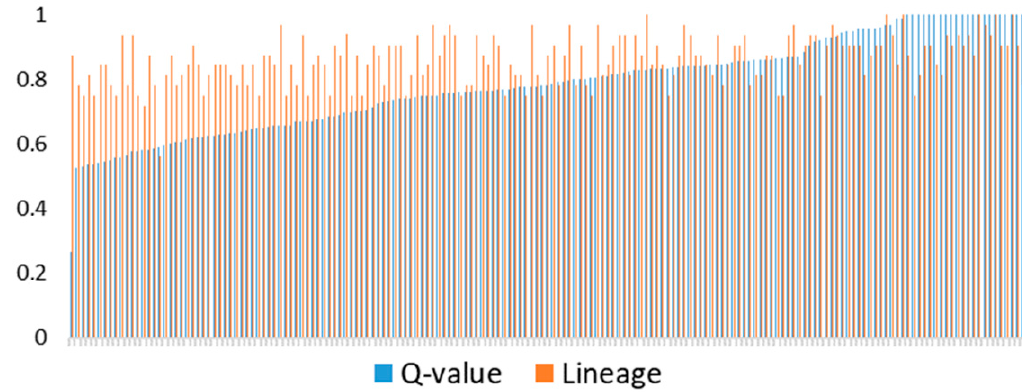
Figure 7. Q-value from Admixture software and lineage from pedigree data for each horse (sorted by